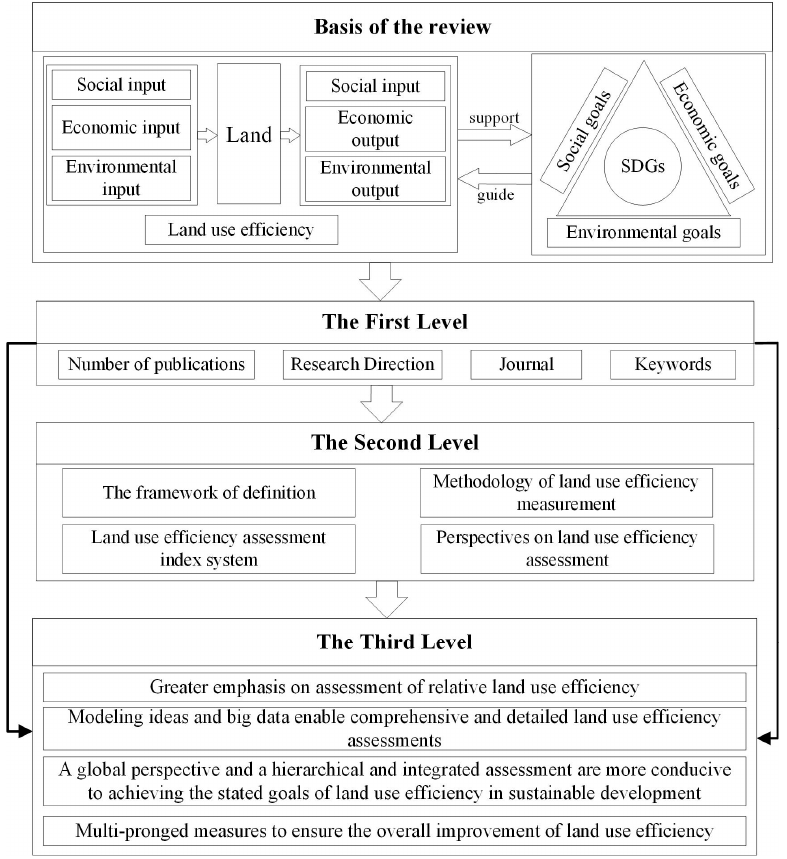
Figure 1. Analytical framework of the review.